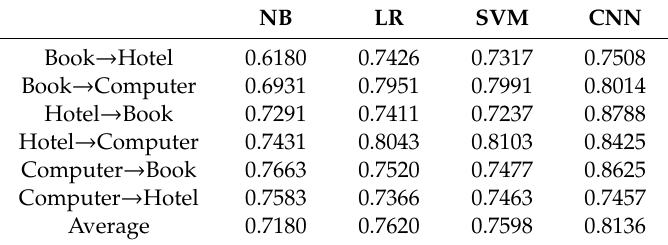
Figure 4. Comparison of different models under different k values. Table 7. Comparison with traditional machine learning methods (k = 500).